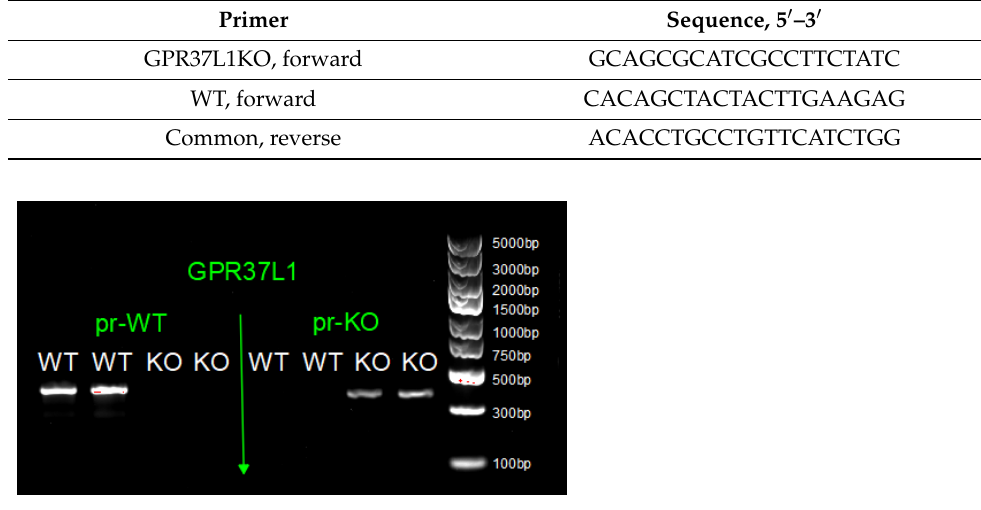
Figure 9. Agarose gel image shows the expected PCR fragments at 366 bp for GPR37L1KO and 385 bp for WT confirming the genotyping for the Table 1. Primers used for GPR37L1 genotyping.